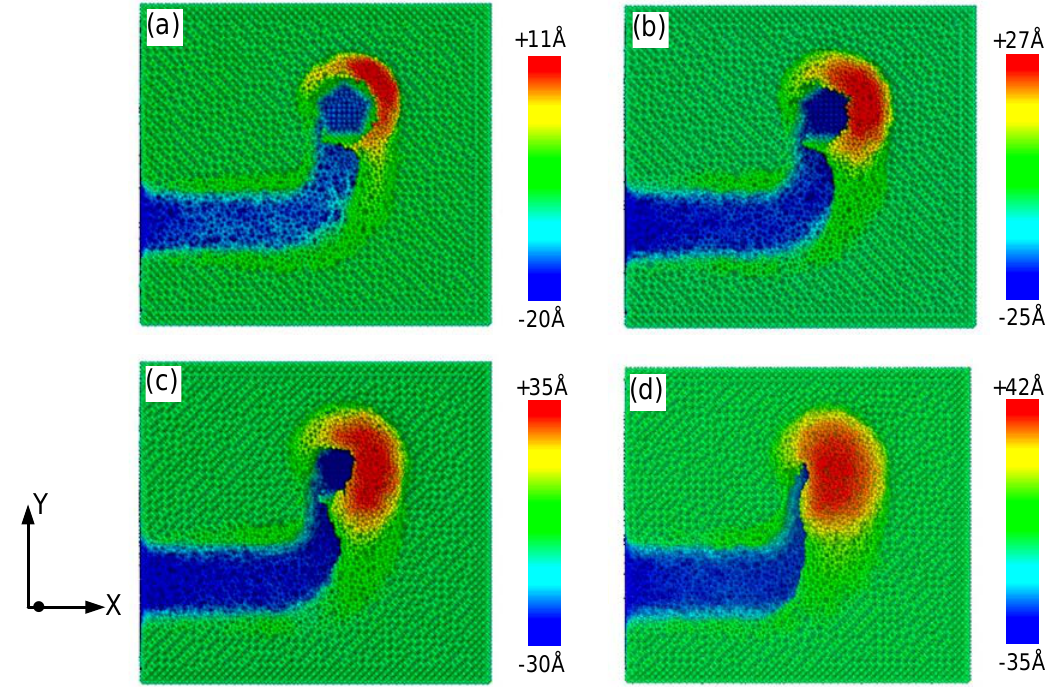
Figure 5. Surface morphologies under the designed grinding depth of: ( a ) 10 Å; ( b ) 15 Å; ( c ) 20 Å; and ( d ) 25 Å after atomic-scale grinding. The colors of atoms were determined by their coordinates on the Z -axis.